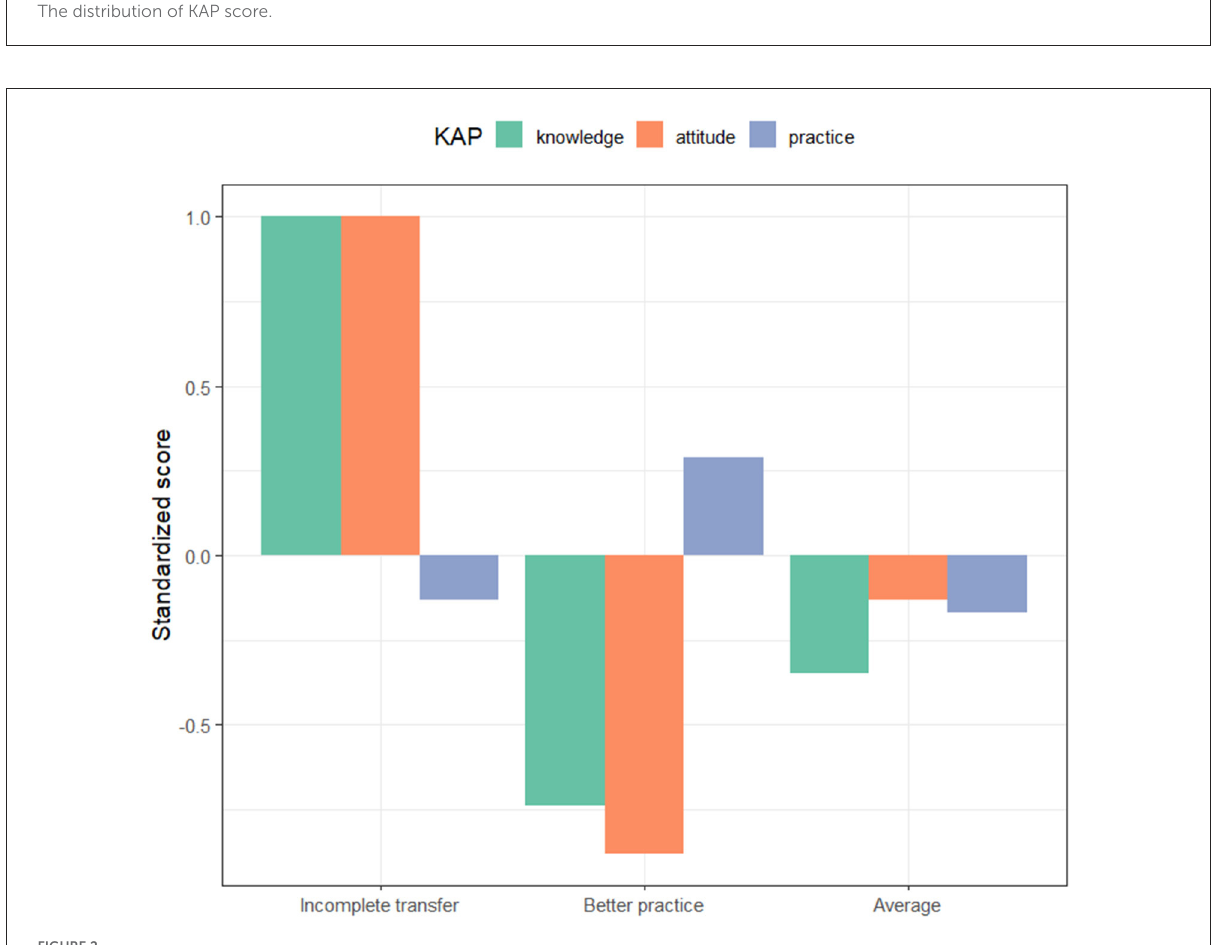
FIGURE2 Participants’ KAP